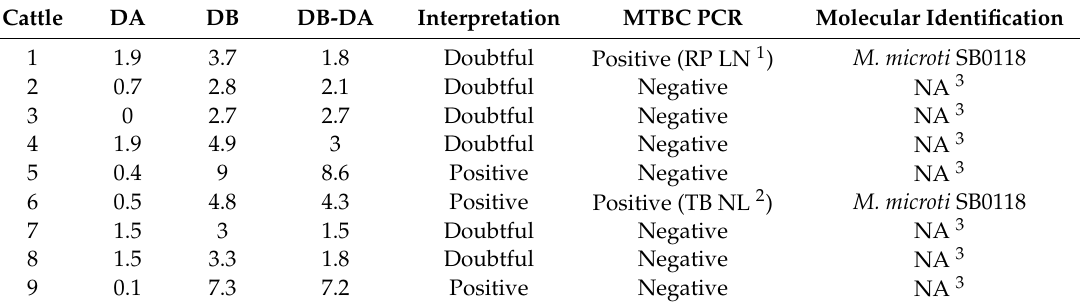
Table 2. Description of bovine tuberculosis diagnosis